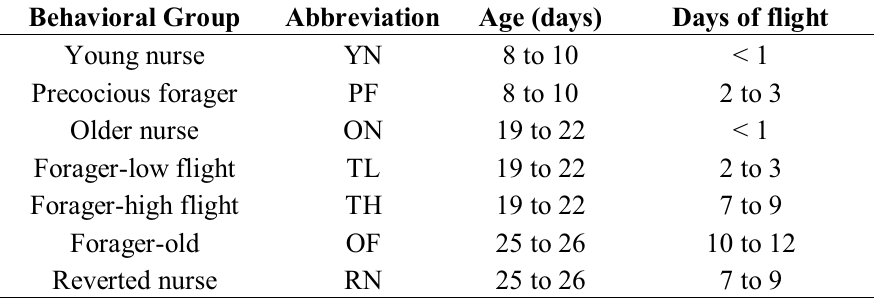
Table 1. Behavioral Groups. Group of nurse bees and forager bees with varying amounts of flight were used in the microarray and real-time PCR experiments. Abbreviations are used throughout